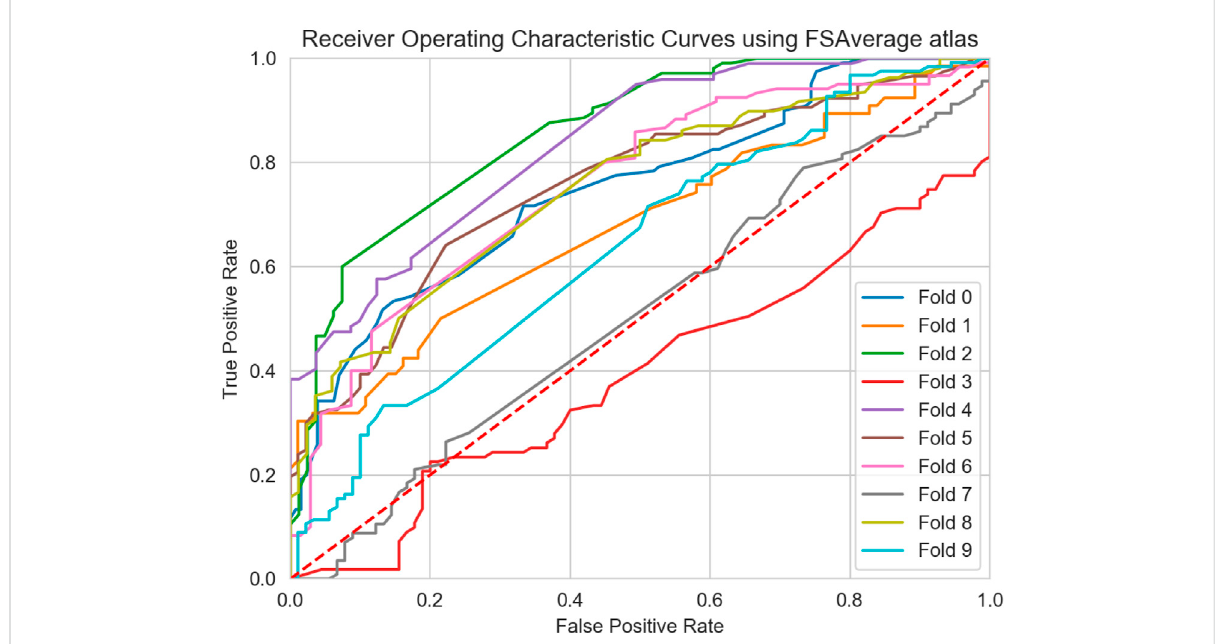
FIGURE 7 Receiver Operating Characteristic Curves (ROC) curve of the ensemble model for all 10-folds of the cross validation using the FSAverage atlas.